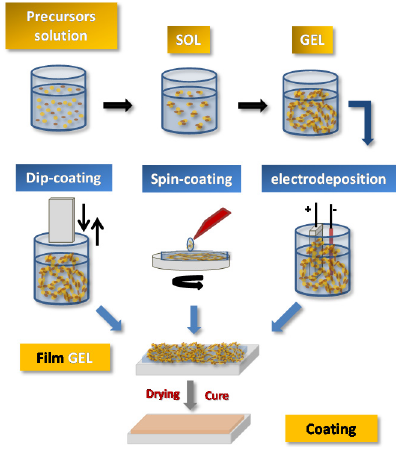
Figure 4. Examples of processing routes to obtain sol-gel coatings. Adapted from [54].